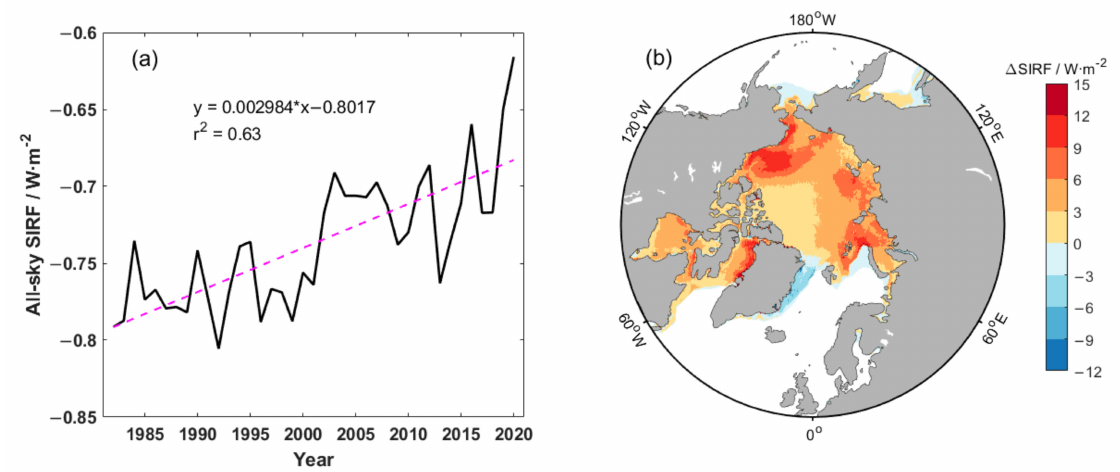
Figure 5. Arctic all-sky SIRF changes from 1982 to 2020. ( a ) Time series of annual mean SIRF in the Arctic. ( b ) Spatial distribution of ∆ SIRF.